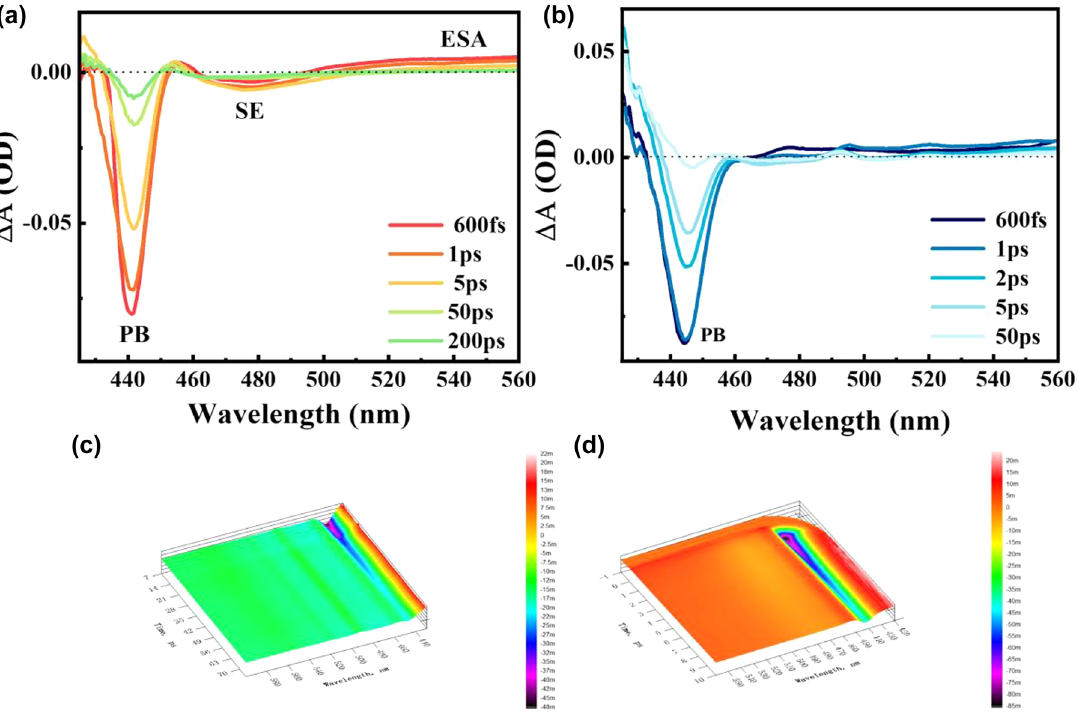
Figure 7: 2D transient absorption (TA) spectra of PQDs (a) and PQDs-G (b) at different delay time, with the excitation at 380 nm. 3D TA spectra of PQDs (c) and PQDs-G